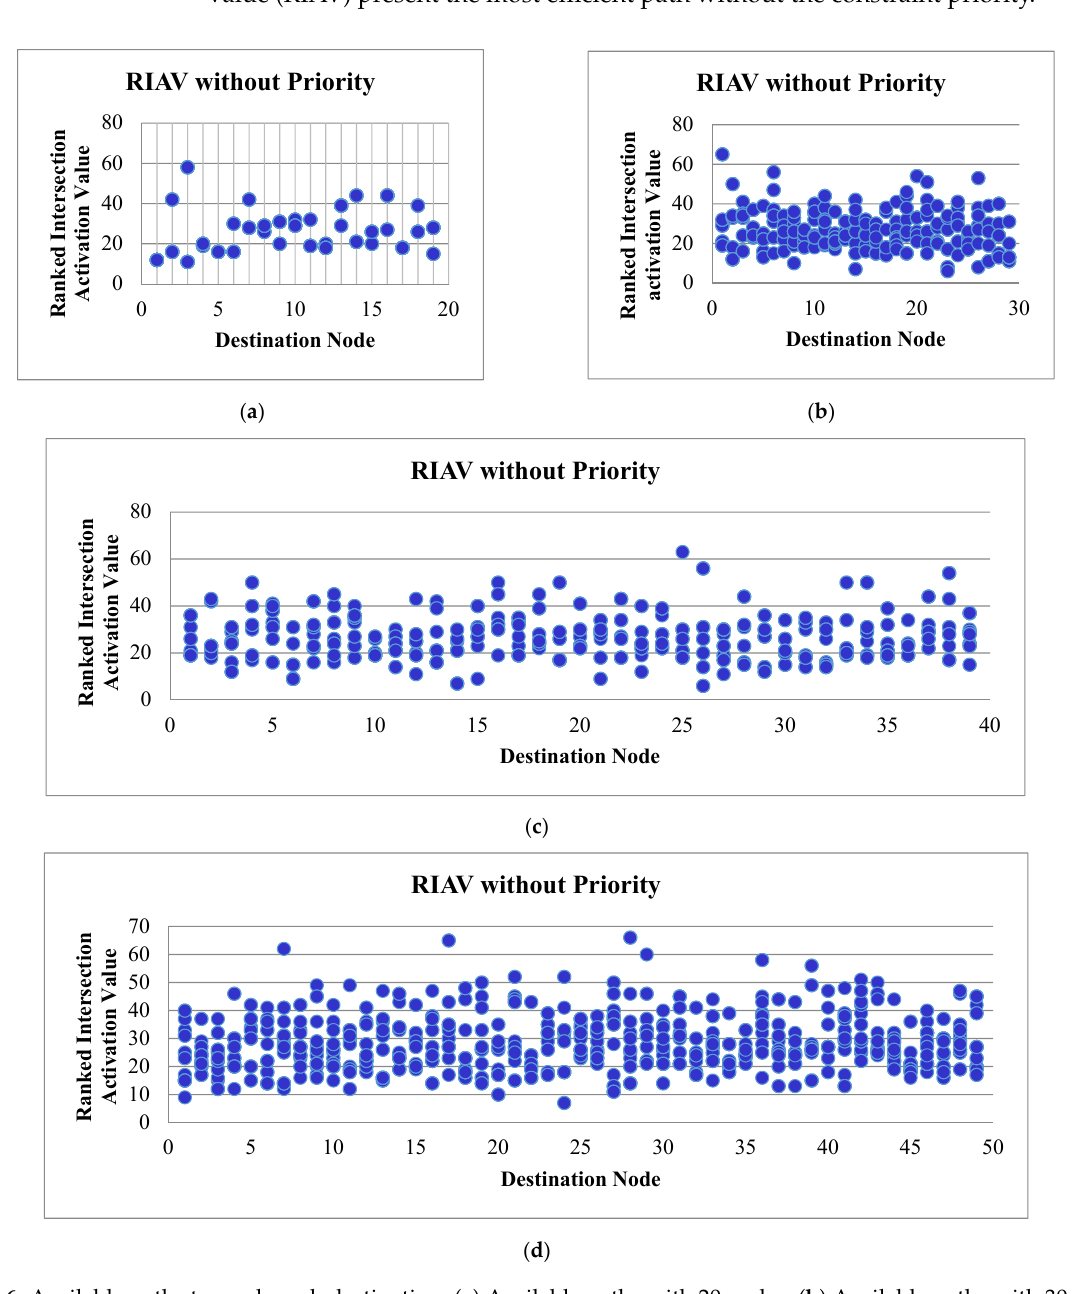
Figure 6. Available paths towards each destination. ( a ) Available paths with 20 nodes; ( b ) Available paths with 30 nodes; ( c ) available paths with 40 nodes; ( d ) available paths with 50 nodes.